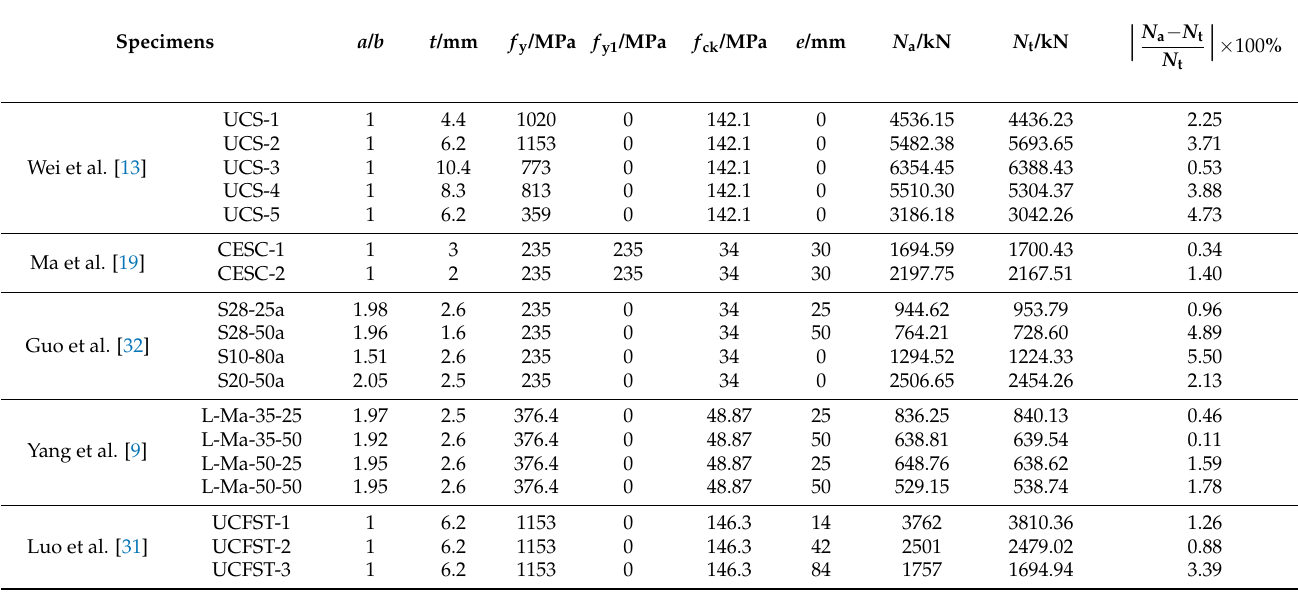
Table 1. The comparison between N a and N t .